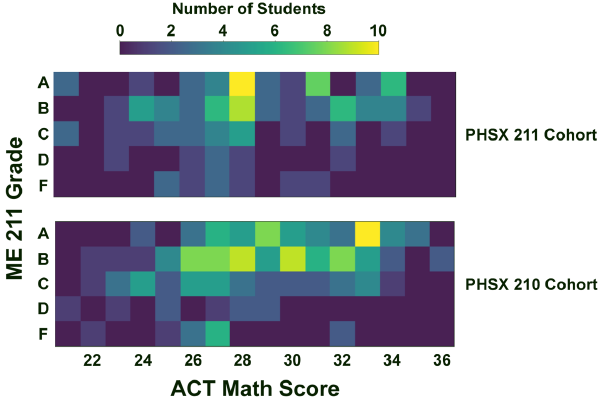
FIG. 3. The grades earned in ME 211 from the fall semester of 2015 through the spring semester of 2018 vs student ’ s highest ACT math score for students who had completed PHSX 211 (top) or PHSX 210 (bottom).